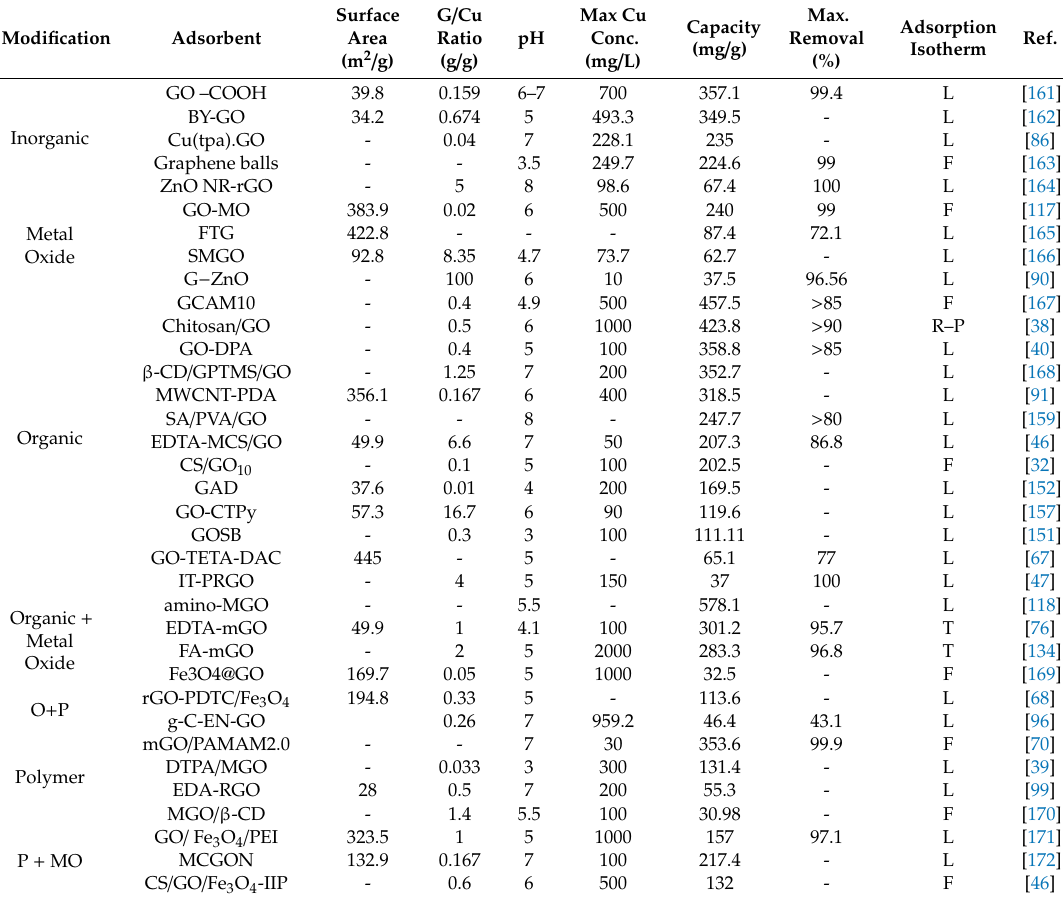
Table 8. Adsorption properties of di ff erent GO-based adsorbents used in Cu (II)